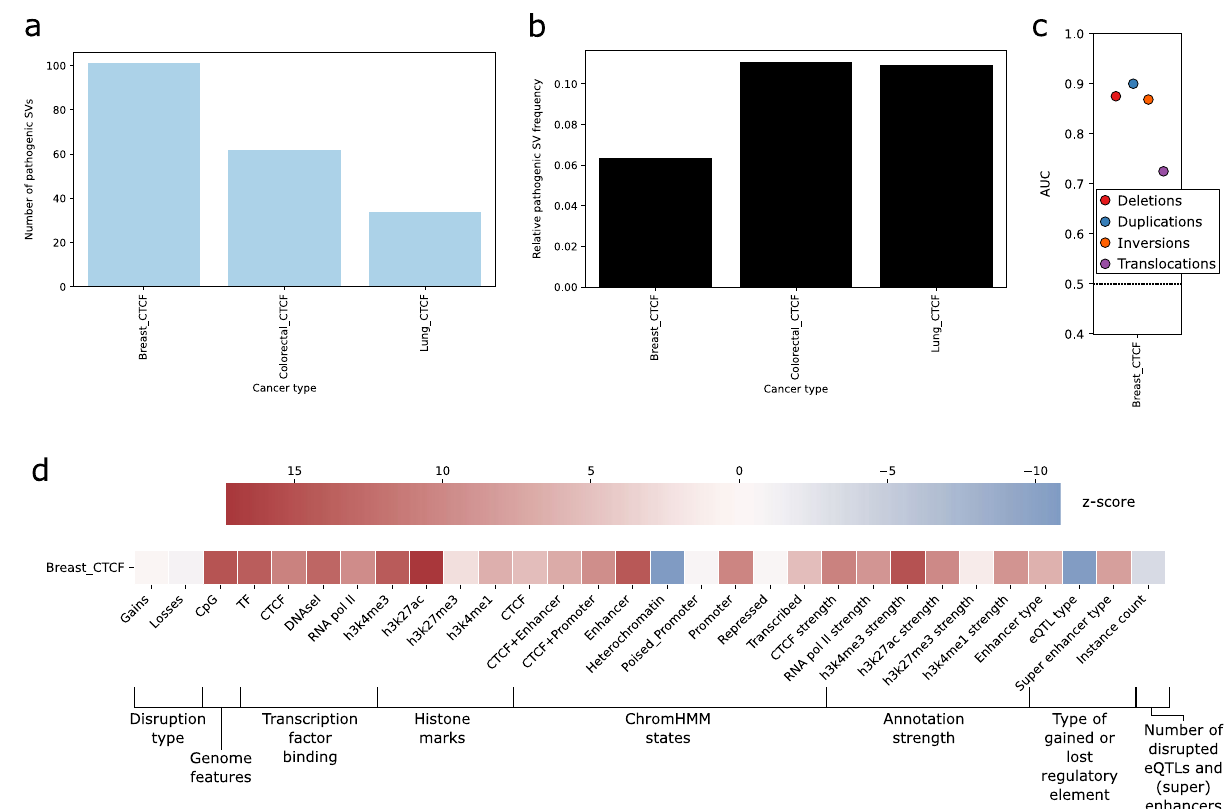
Figure 5. Performance of svMIL2 when intra-chromatin CTCF loops are used in place of TADs. (a) Number of pathogenic SV-gene pairs identified to disrupt chromatin loops and (b) the percentage of the total SV-gene pairs these comprise. (c) AUC of svMIL2 when predicting pathogenic SVs using chromatin loops. (d) Regulatory elements more or less frequently disrupted than by random chance for SVs affecting chromatin loops. The colors represent the